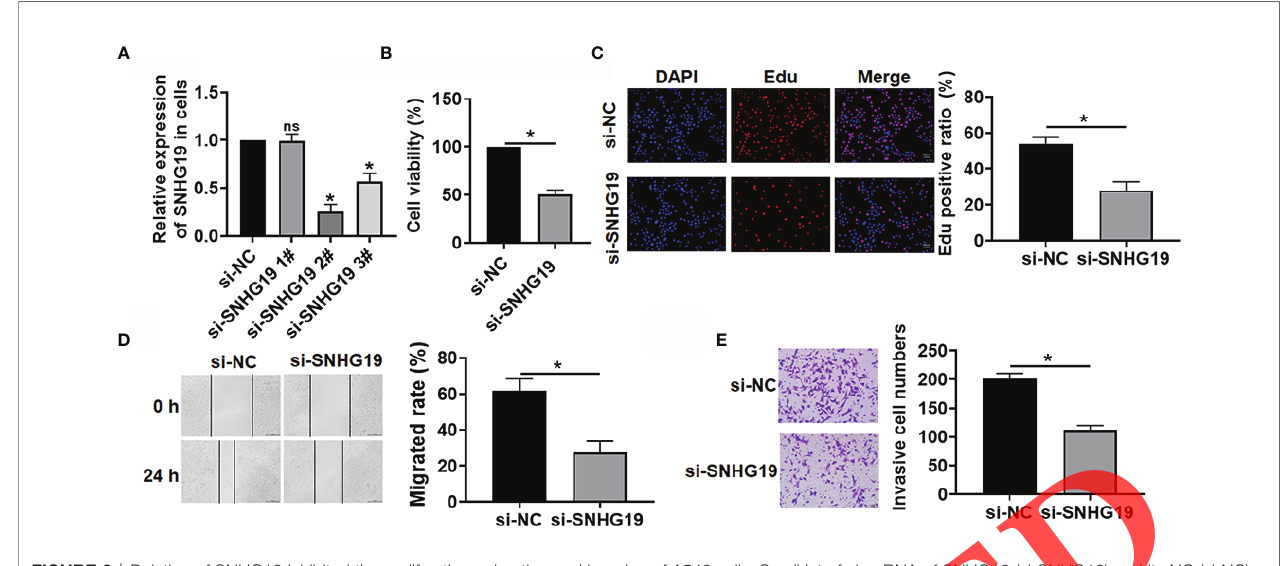
FIGURE 2 | Deletion of SNHG19 inhibited the proliferation, migration and invasion of A549 cells. Small interfering RNA of SNHG19 (si-SNHG19) and its NC (si-NC) were transfected into A549 cells. (A) The knockdown ef fi ciency of si-SNHG19 was determined by qRT-PCR. (B) MTT assay used to detect cell viability. (C) EdU assay was to detected proliferation of A549 cells. Scale bar, 20 m m. (D) Wound healing assay was to evaluate migration of A549 cells. Scale bar, 100 m m. (E) Transwell assay was to examine invasion of A549 cells. Scale bar, 50 m m. Data are mean ± SD; *P < 0.05. All experiments were repeated three times. ns, no signi fi